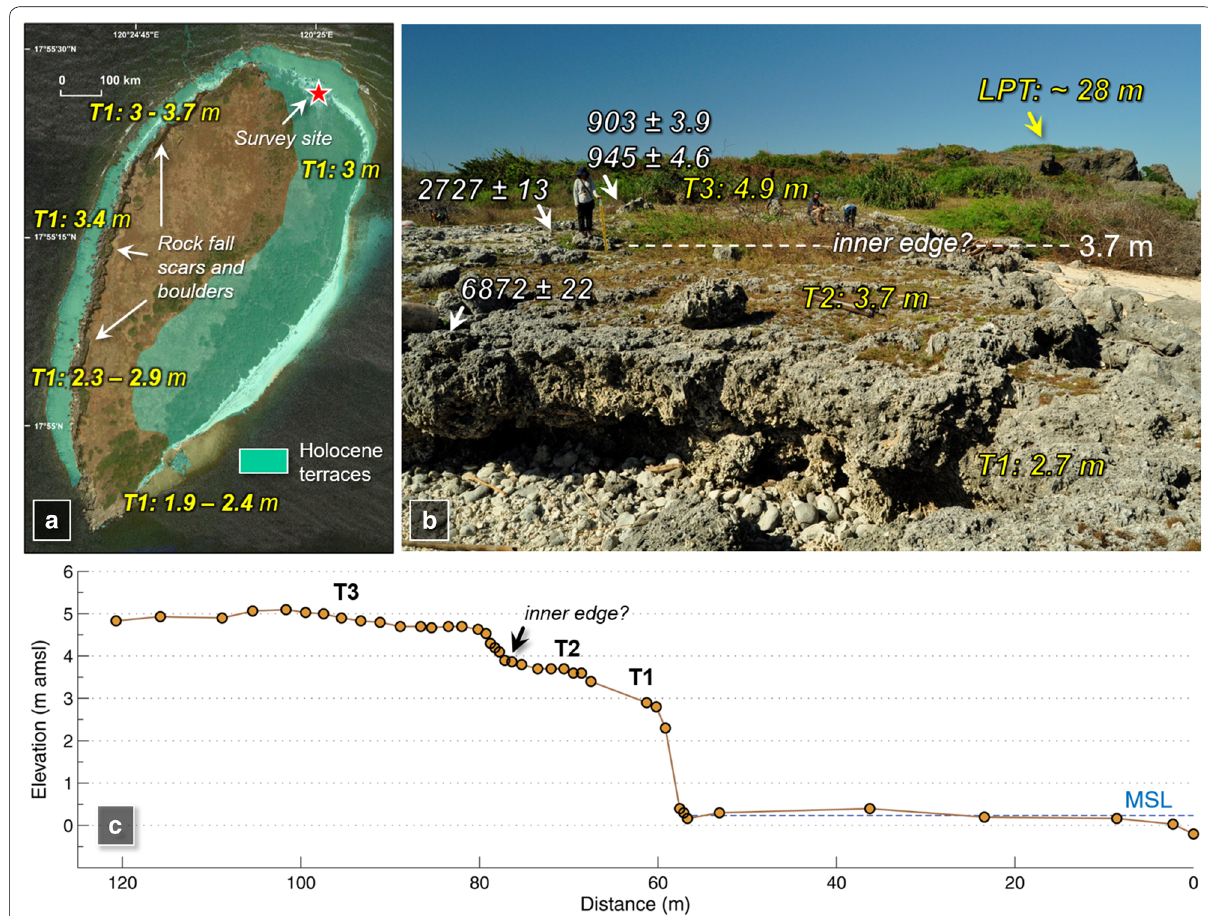
Fig. 2 Geomorphic features in Badoc Island. a Emergent Holocene terraces and fringing reefs surround the island. Numbers indicate varied eleva‑ tions of the lowest terrace, in which higher T1 surfaces are observed to the northwest. The island is inferred to be slightly tilted to the southeast based on variable T1 elevations. b At one site to the north, possibly three Holocene terrace surfaces were recognized and these rise up to about 5 m amsl. Elevations (meters above mean sea level, m amsl) and 230 Th ages (relative to 1950 AD, years BP) of fossil corals collected are shown in white and yellow , respectively. Highest reef platforms at about 20‑28 (possibly rising up to ~35) m amsl are inferred to represent the Late Pleistocene ter‑ races (LPT). c Topographic profile at the survey site showing the measured elevations of the terraces and inner edge , when observed. Mean sea level (MSL) ( blue dashed line ) is 0.24 m and is derived from actual tide data of